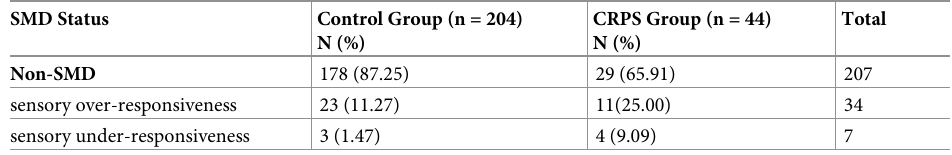
Table 2. Distribution of SMD subtypes within and between groups (N = 248).